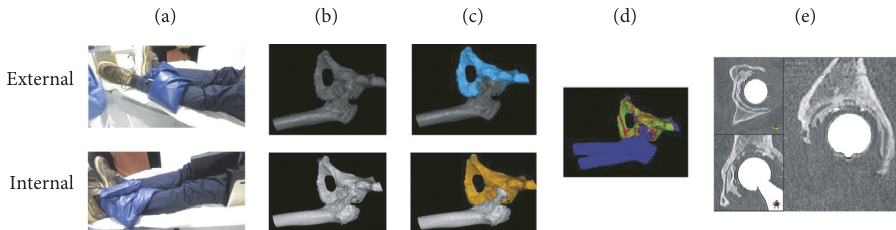
Figure 2: Workflow for (a) image acquisition, (b–d) processing, and (e) visualization. The moving image overlay is a key feature and can be